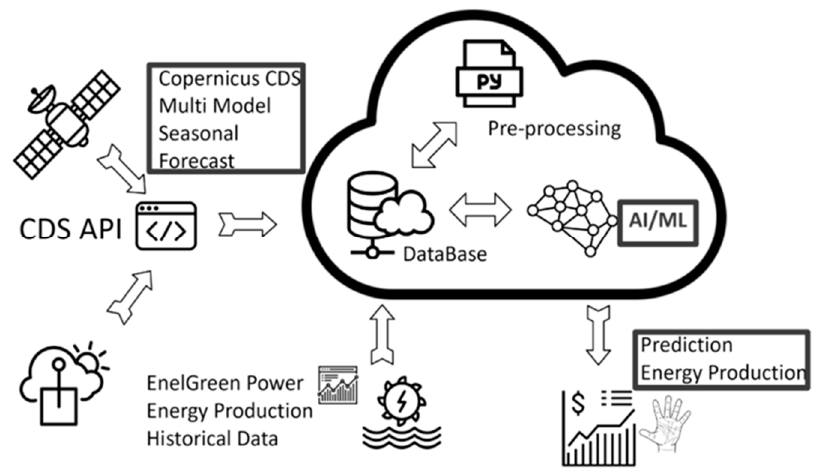
Figure 2. Schematic representation of SCHT as a climate service.